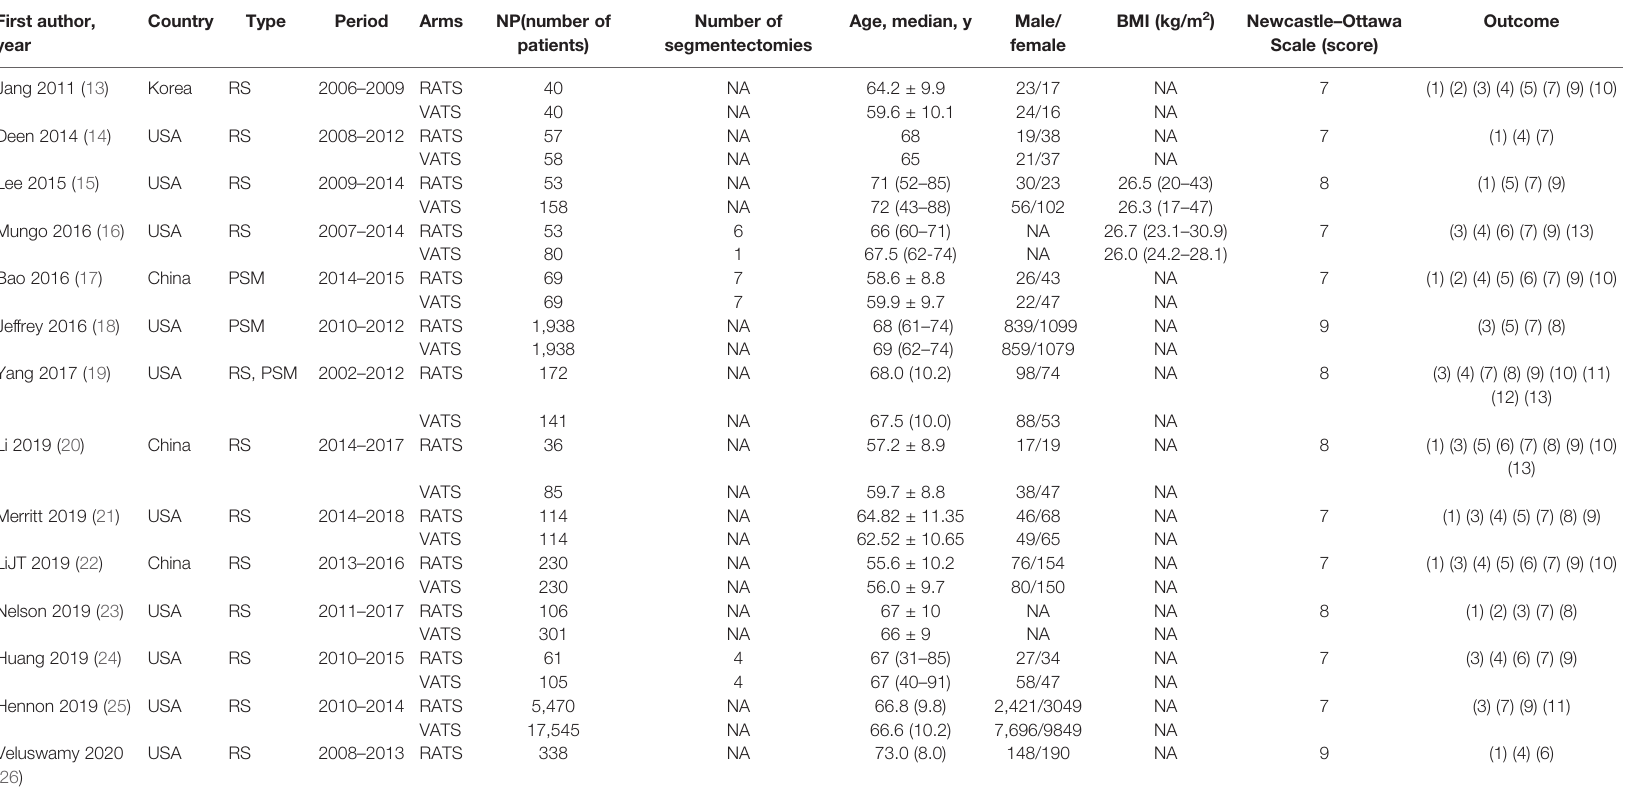
TABLE 1 | The main characteristics and NOS of the included